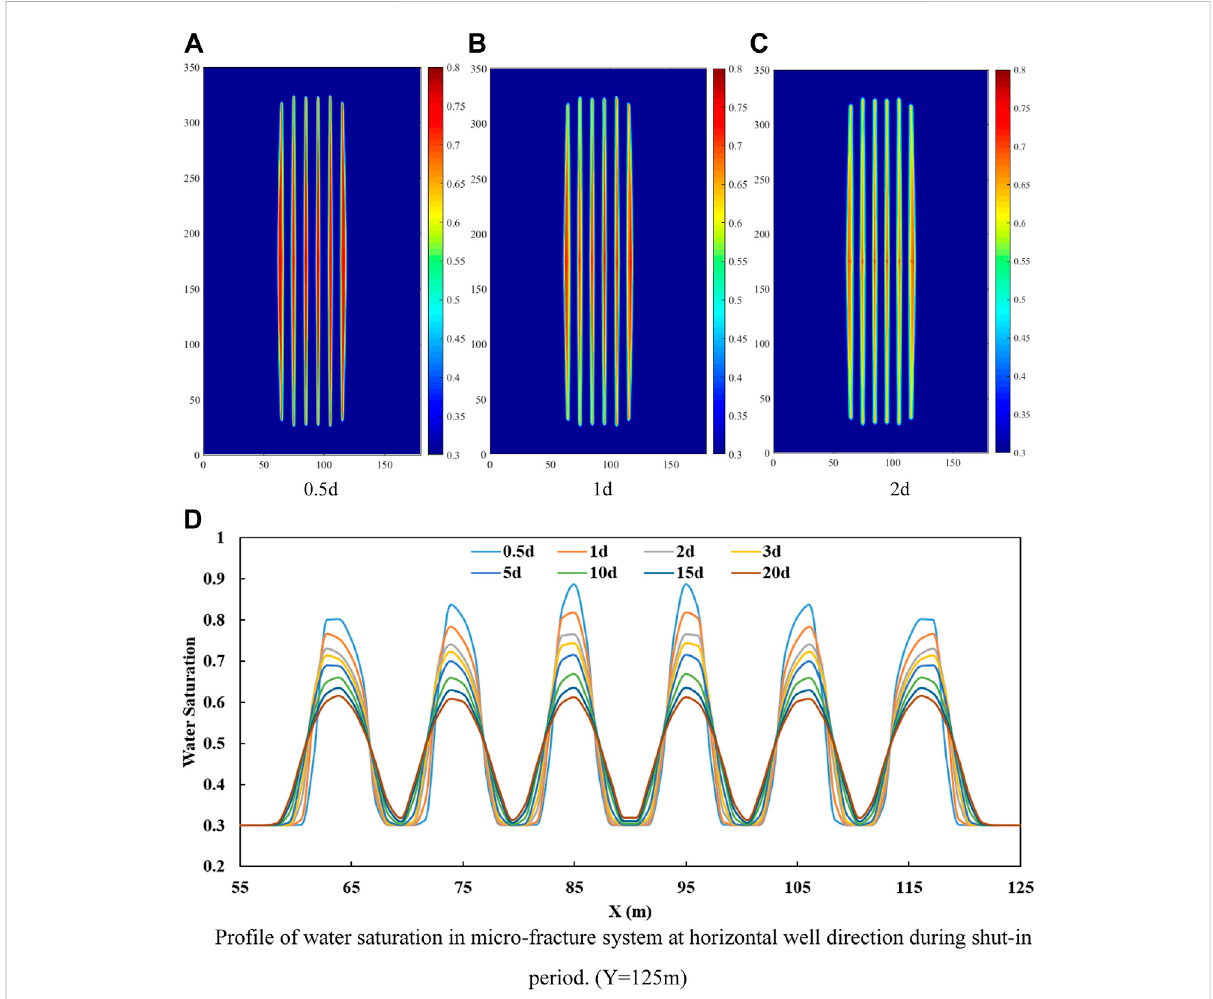
FIGURE 9 Distribution of water saturation in micro-fracture system during shut-in period. (In (A – C) , the range of water saturation is from 0.3 to 0.8. (D) is pro fi le of water saturation which is drawn from the data in the fi gure of water saturation distribution in micro-fracture system during shut-in period (such as (A – C) and so